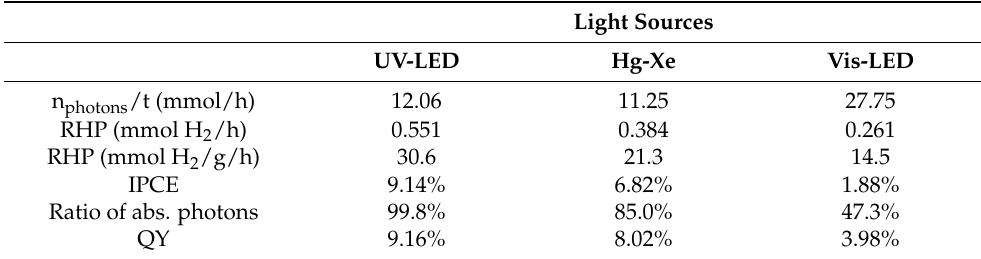
Table 5. Measured data for the calculation of IPCE and QY for the Cat-2N catalyst illuminated by different light sources, and the resulting IPCE and QY values.